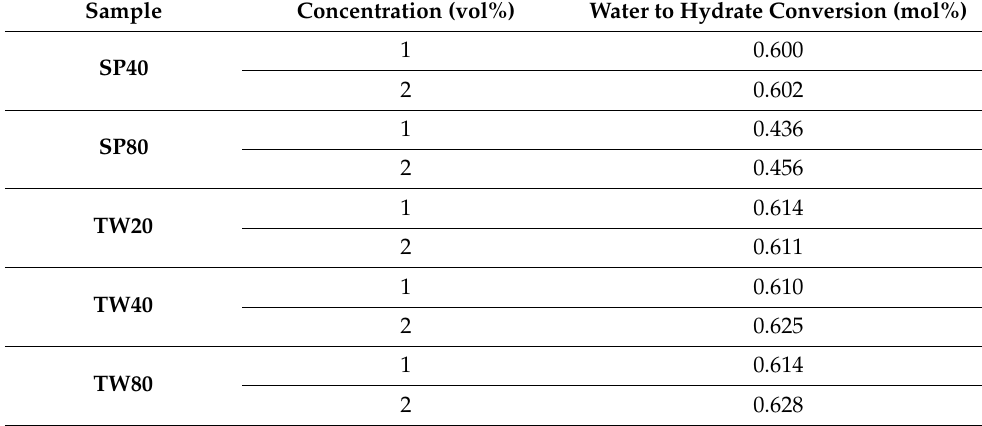
Figure 10. The effect of concentration of nonionic surfactant on: ( a ) rate of hydrate formation and ( b ) degree of gas consumption.